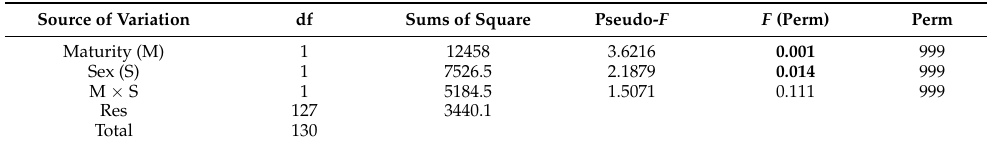
Table 3. Factorial PERMANOVA to test differences between maturity stage and sexes in diet contri- bution from 16 prey items.